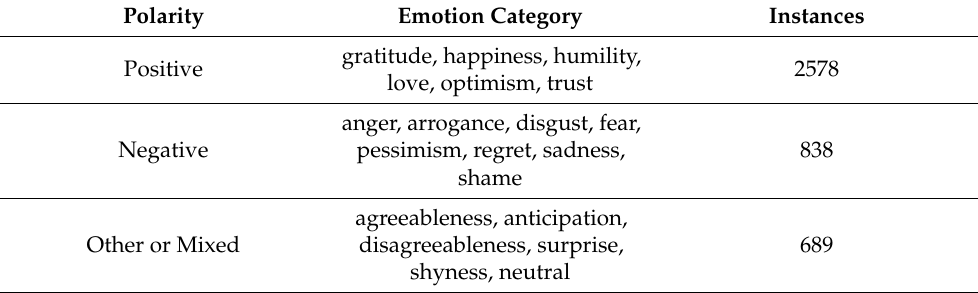
Table 1. Main characteristics of the dataset used in the experiment.